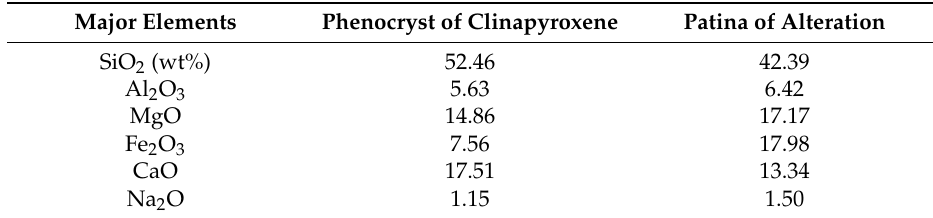
Table 3. Mean values of the major elements (wt%) of clinopyroxene phenocrysts in comparison with the patina of alteration developed on it, as obtained using the EDS